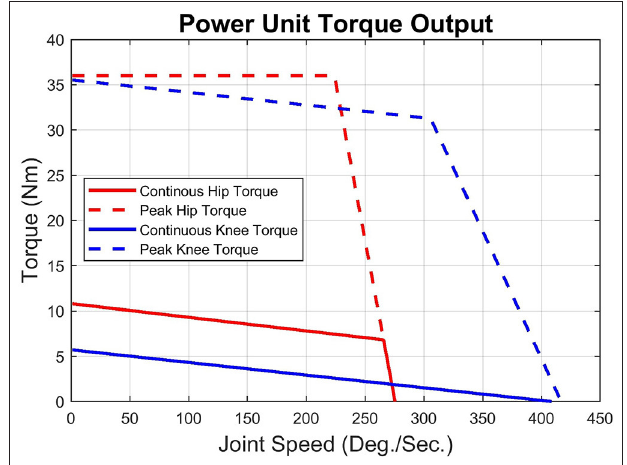
FIGURE 3 | Net torque operating